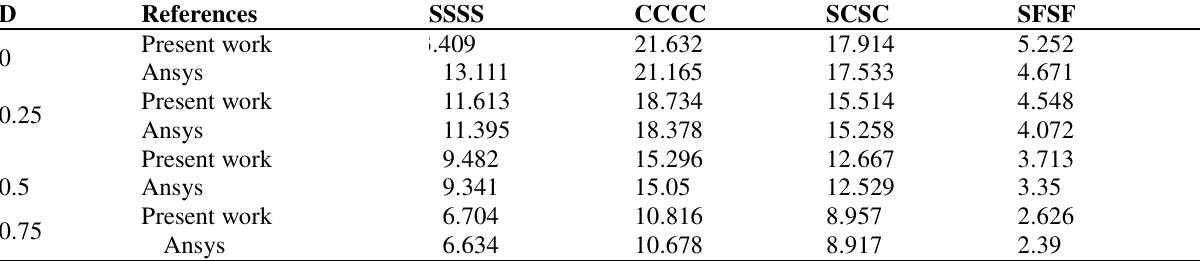
Dimensionless natural frequency plates under buckling of different load ratios, (